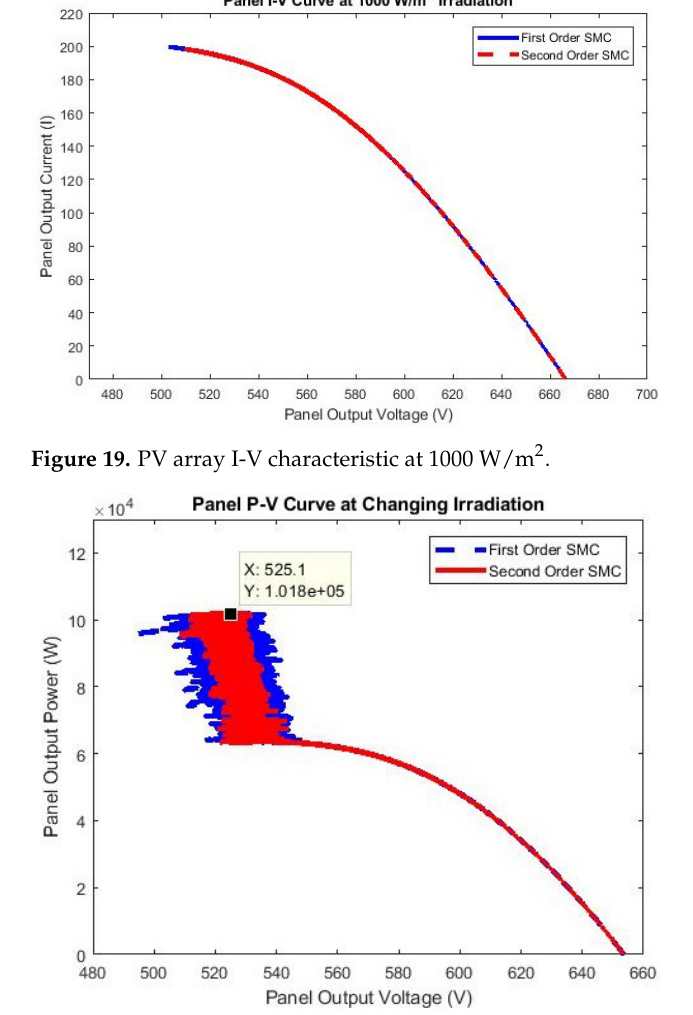
Figure 20. PV array P-V characteristic under changing irradiation.